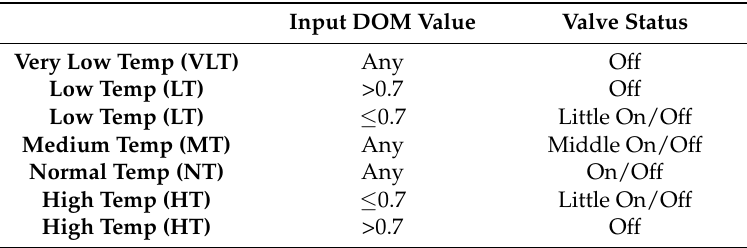
Table 2. FITRA Interrupt state degree of memberships table.